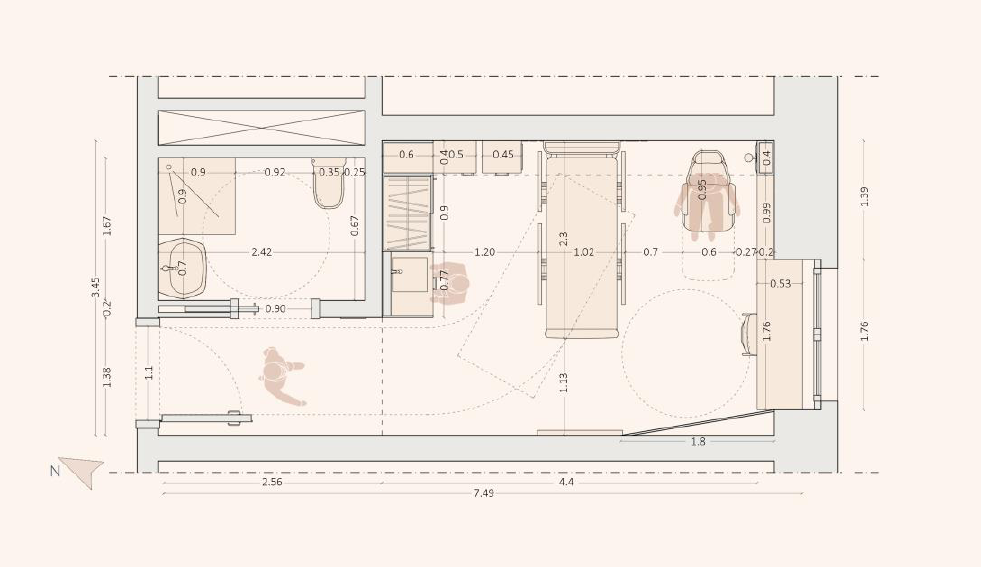
Figure 10. Floor plan of the room after the furniture design.